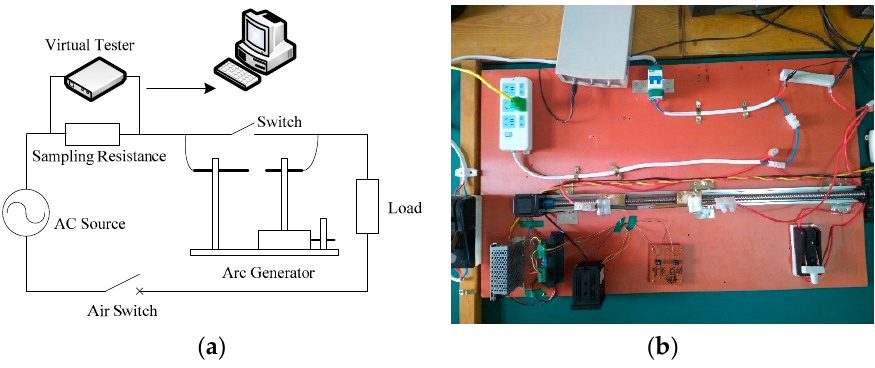
Figure 6. Series arc faults experiment platform: ( a ) schematic; ( b ) actual platform.